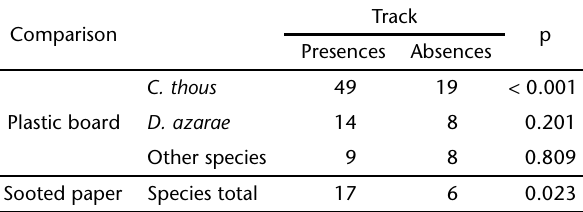
Table III. Number of track presences and absences on artificial tracking methods, given the occurrence of animals in the tracking